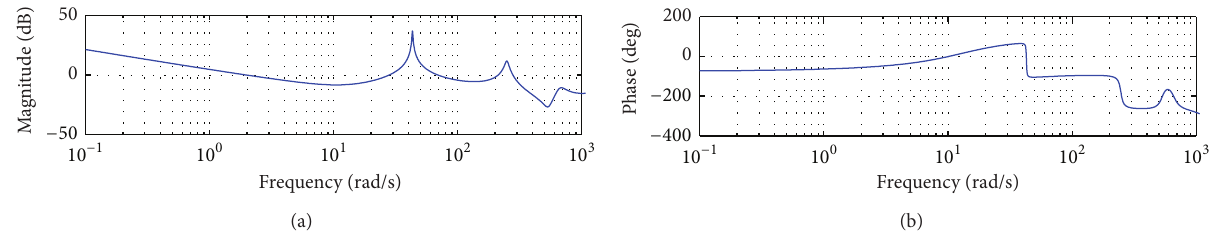
Figure 8: Bode characteristic of the open-loop transfer function based on the fractional PID controller and the FE model: (a) magnitude, (b)